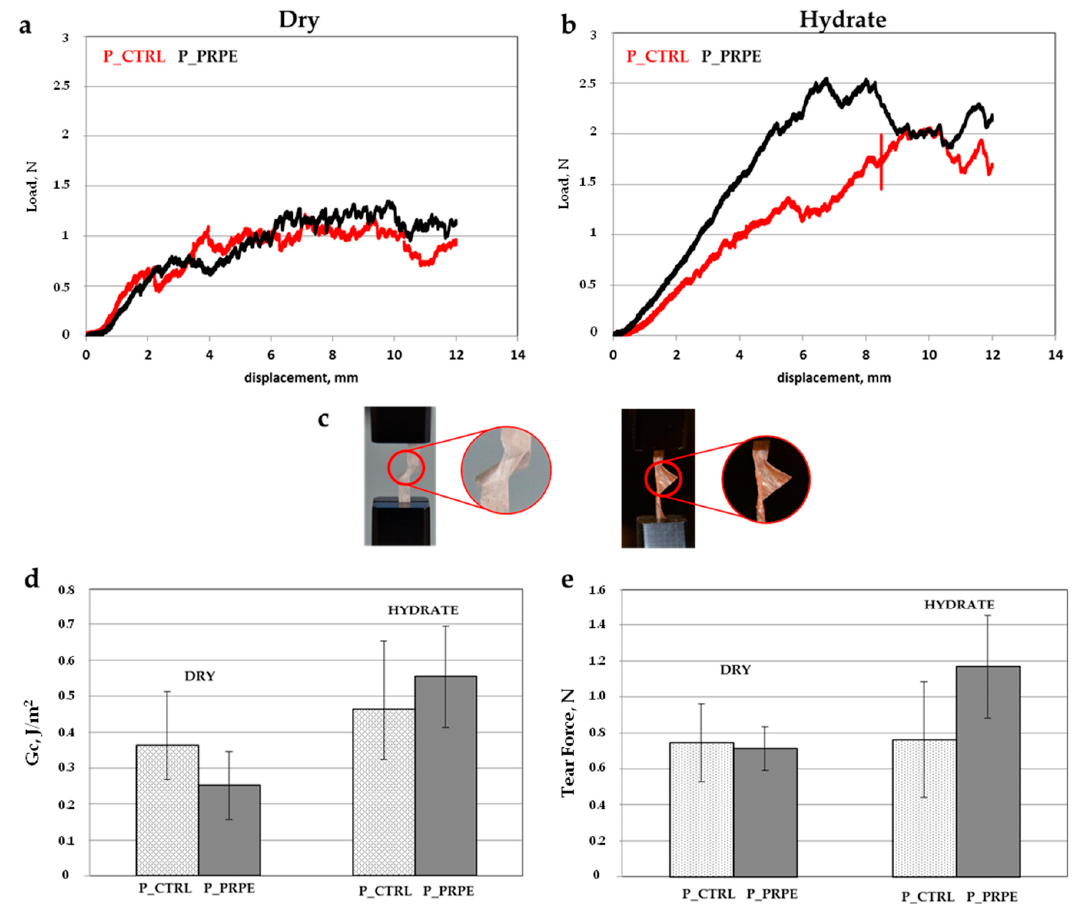
Figure 11. Tear test of P_CTRL and P_PREP membranes. ( a ) and ( b ) displacement-force curve in dry and hydrate conditions for P_CTRL and P_PRPE membrane. ( c ) Picture of the effect on P_CTRL (left) and P_PRPE (right) due to the tearing stress. ( d ) Histogram of the energy required to tear in both dry and hydrate conditions for P_CTRL and P_PRPE. ( e ) Maximum tear load in hydrate and dry conditions for P_CTRL and P_PRPE membranes.